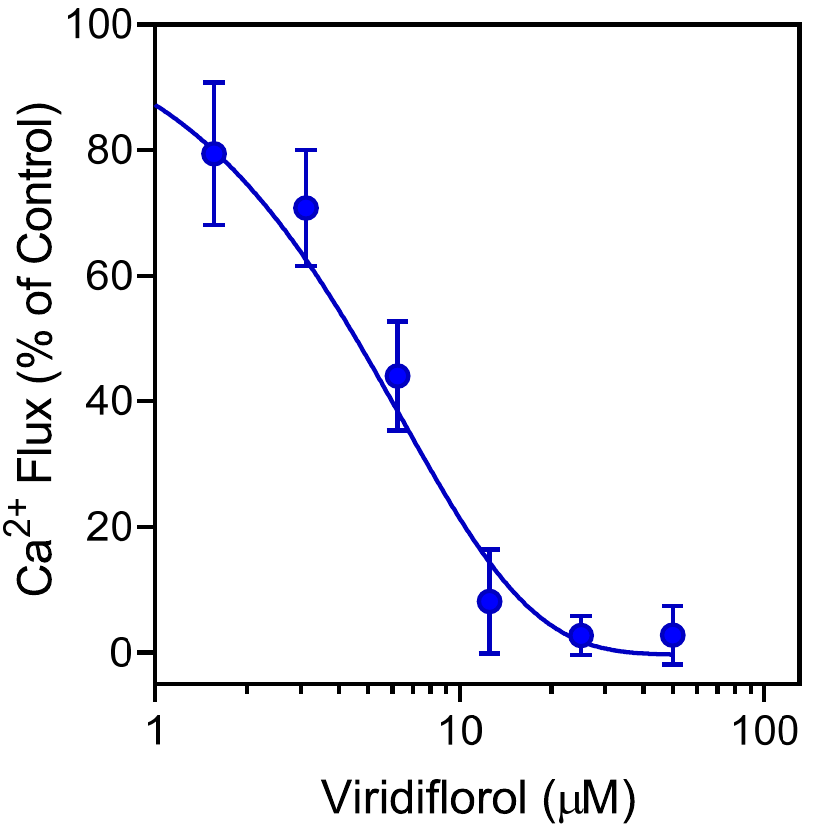
Figure 4. Effect of viridiflorol on neutrophil Ca 2+ mobilization. Human neutrophils were treated with the indicated concentrations of viridiflorol or 1% DMSO (negative control) for 10 min. The cells were activated by 5 nM f MLF, and Ca 2+ influx was monitored as described. The data are from one experiment that is representative of three independent experiments.